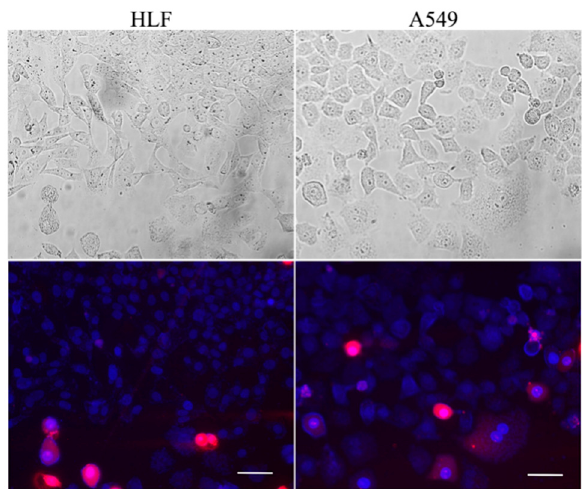
Figure 4. Viability of cells cultured on the co-culture device after 48 h. The top pictures are bright field and the bottom ones are merged fluorescence images. Fluorescent staining showed mostly living cells (blue) mixed with a few apoptotic cells (red). Scale bar = 50 μ m.